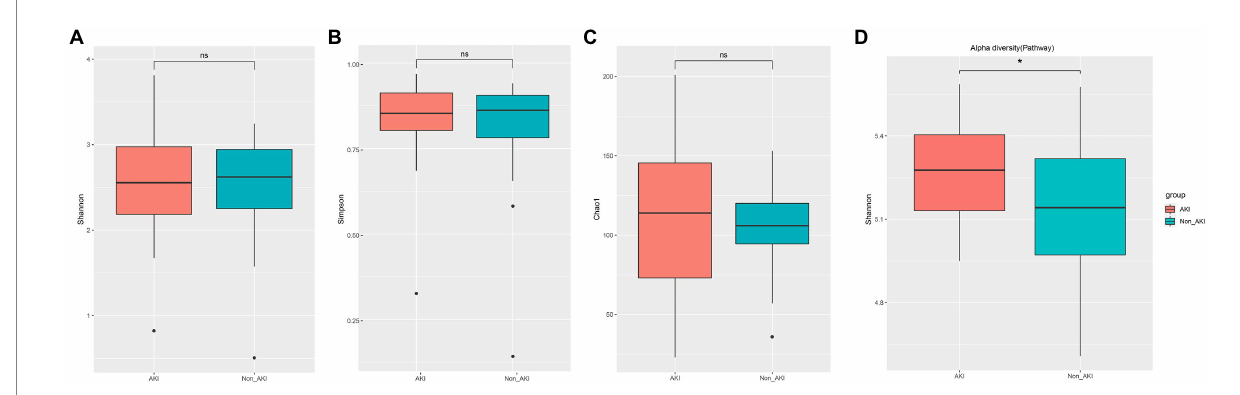
FIGURE 1 Comparison of gut microbiota α -diversities between the AKI and Non_AKI groups. Gut microbiota α -diversity according to Shannon index (A) , Simpson index (B) , Chao1 index (C) at the species level, and Shannon index at the functional pathway level (D) . Threshold for statistical significance: p = 0.05. * means P <